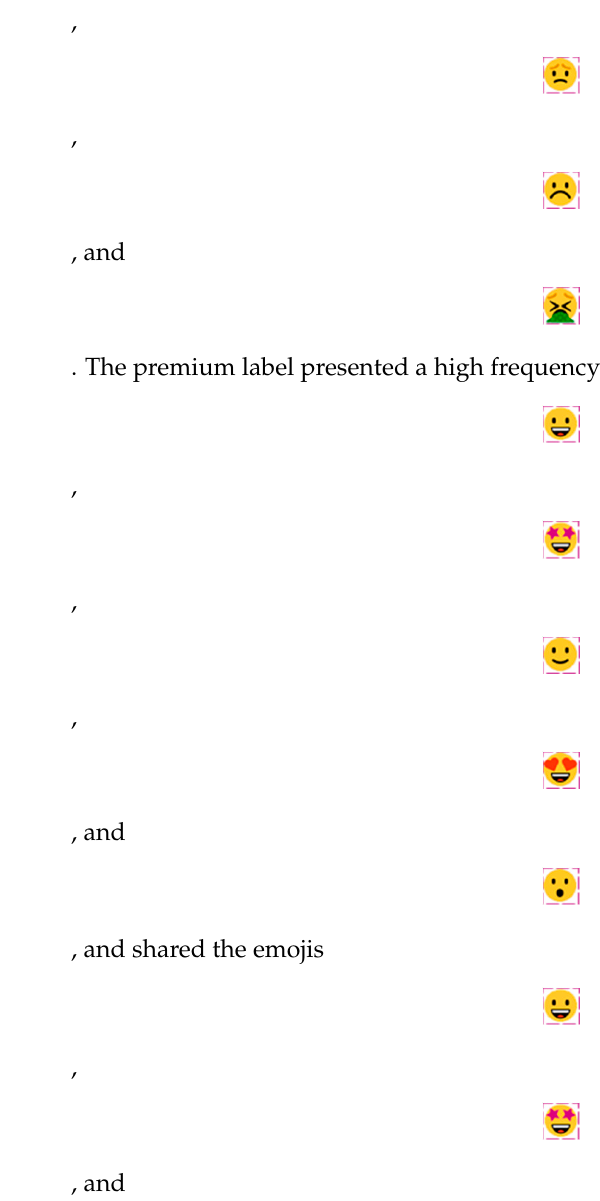
Table 1. Attributes assessed for acceptability of the coffee pod label samples.